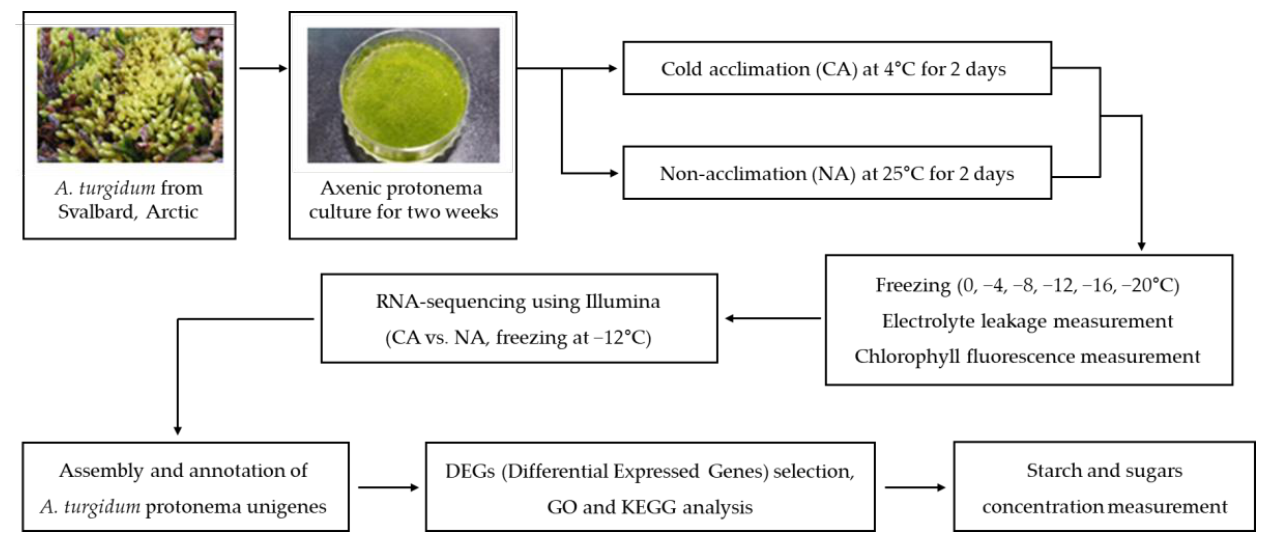
Figure 1. Workflow diagram summarizing the analysis process used in this study.